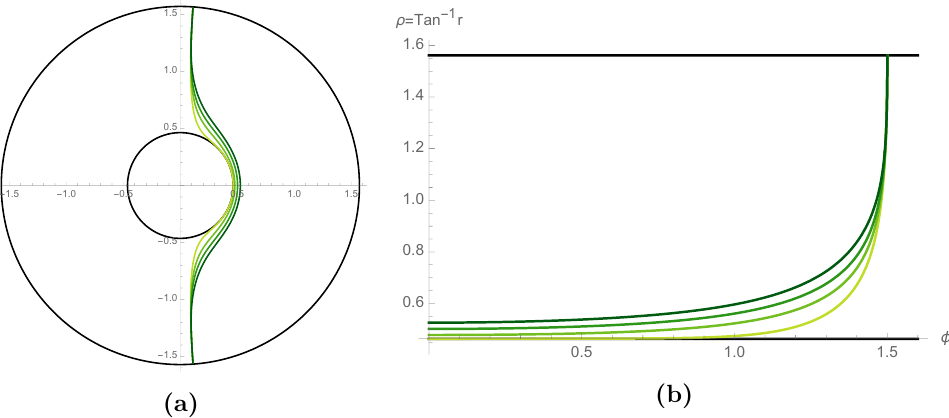
Figure 5. Entanglement minimal surfaces (cid:0) A for (cid:12)xed boundary region A of size parametrized by the polar angle (cid:30) A . We have set r h = 0 : 5 and (cid:30) A = 1 : 5. (a) From lighter to darker